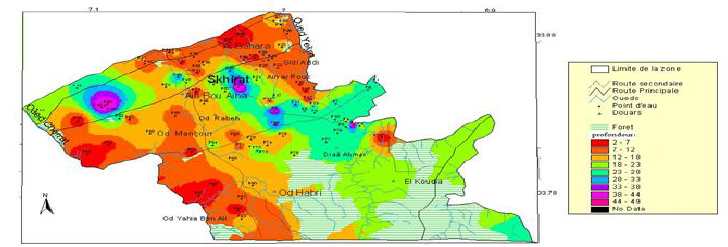
Figure 2. Spatial distribution of the water table depth.